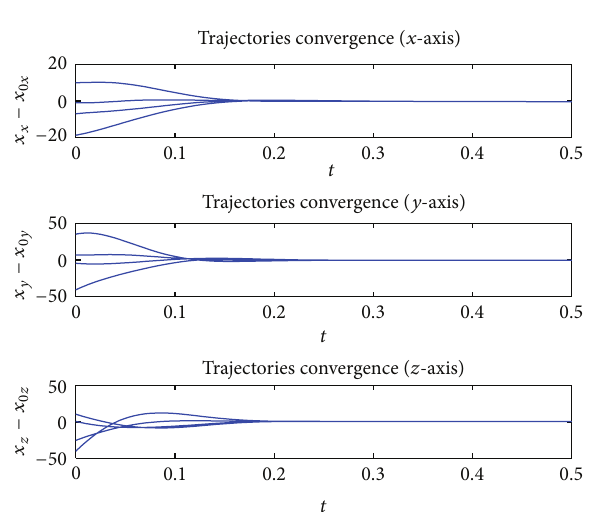
Figure 3: The trajectories of four agents in the dynamical network with a state predictor when 𝛾 = 200